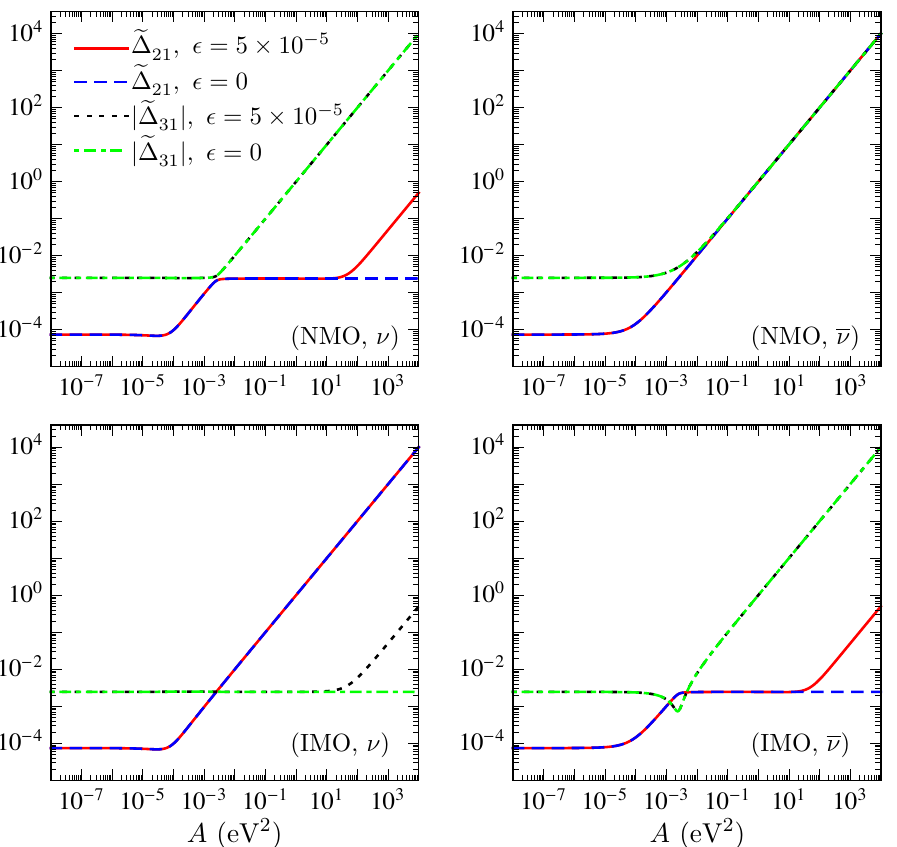
Figure 1 . In the standard three-(cid:13)avor mixing scheme, the illustration of how the e(cid:11)ective neutrino mass-squared di(cid:11)erences or without radiative corrections, where the best-(cid:12)t values of ( (cid:18) have been